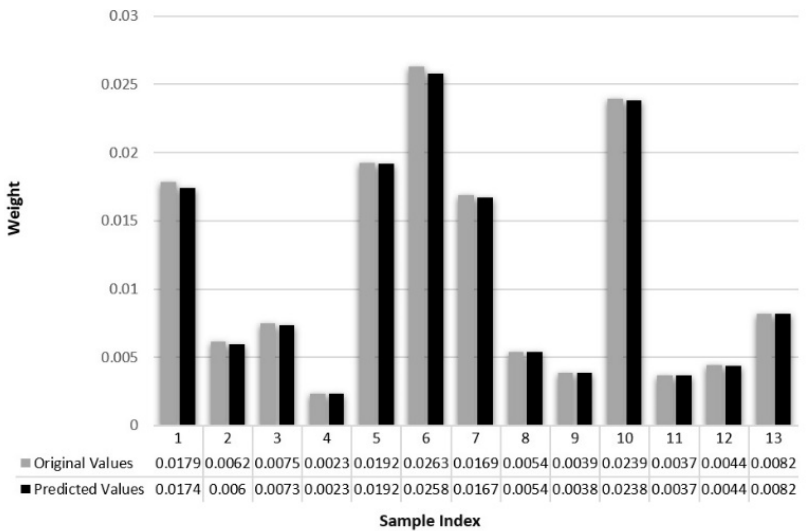
Figure 13. Graphical representation of the predicted and true weight values of the rice kernel.